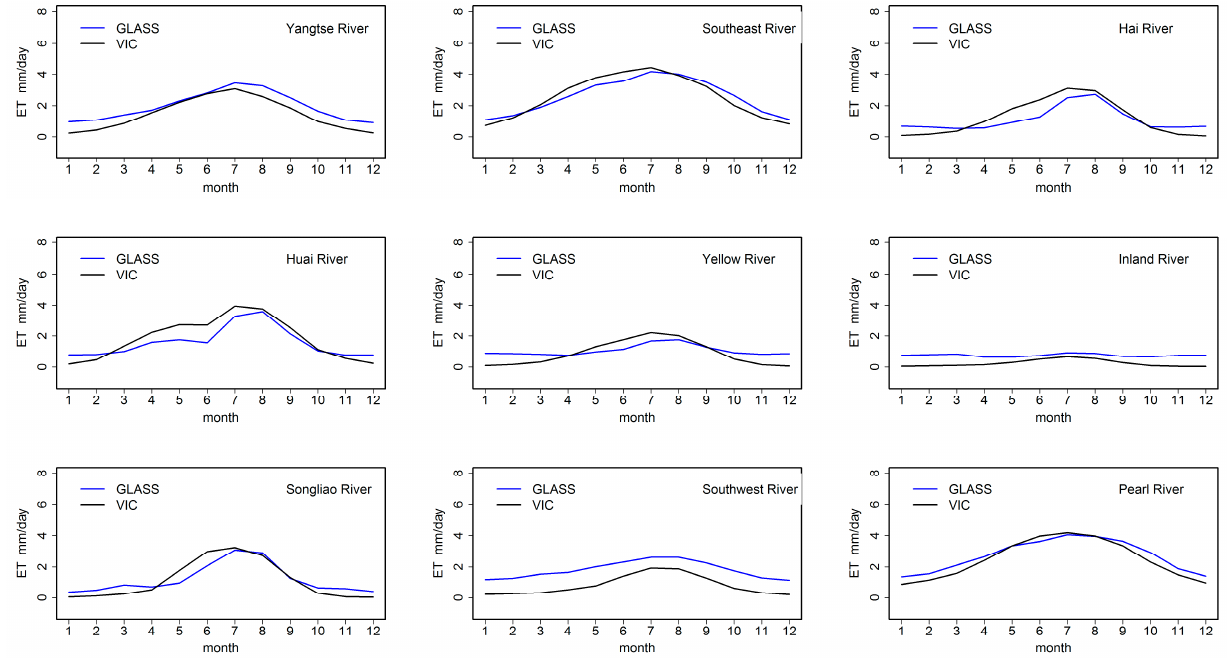
Figure 5. Statistics for comparisons between observations and simulations of ( a ) ET and ( b ) SM in each basin. The x and y axes indicate the standard deviation.